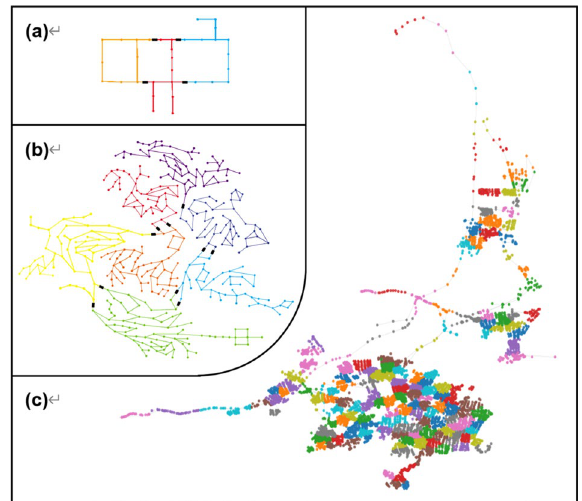
Figure 5. The water network structure and partitioning results ( a ) Hanoi ’s water network ( b ) C-Town’s water network ( c ) E-Town’s water